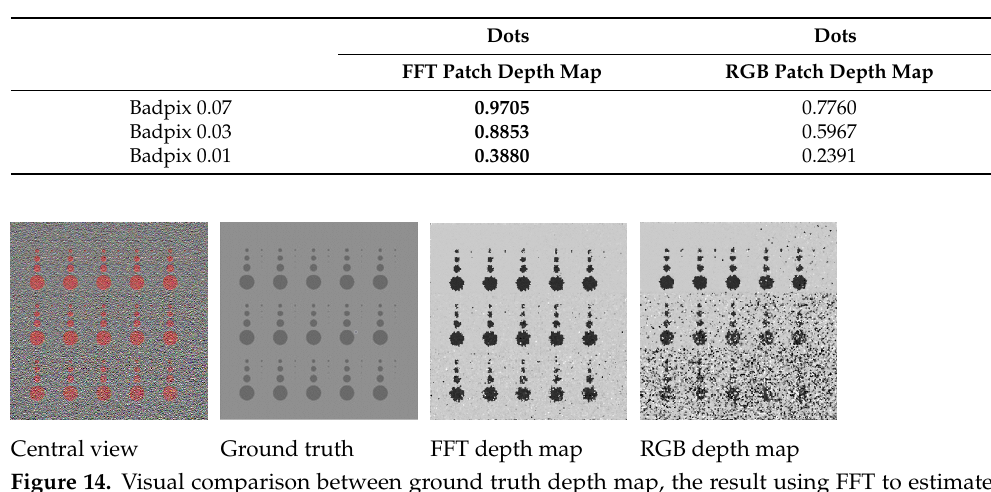
Table 1. Comparison of the estimated depth map when using the FFT Patch and RGB Patch algorithms.